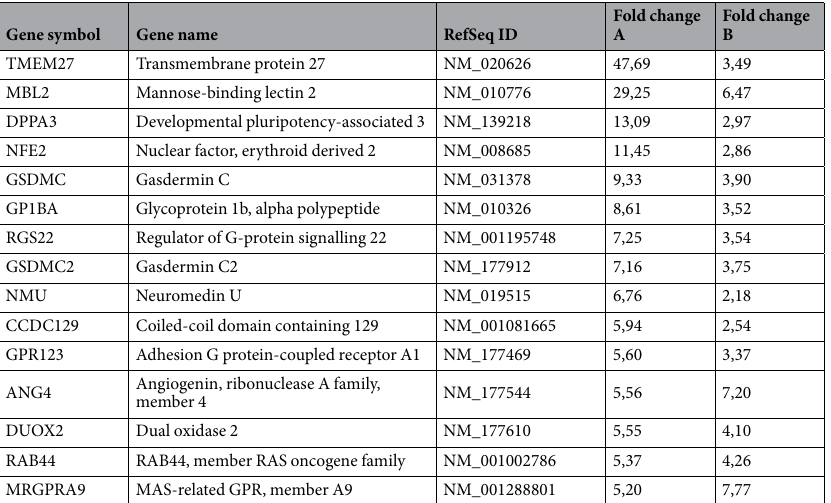
Table 3. Top 15 most upregulated genes as identified by RNA-seq that differentially respond to infection in C57BL/6 WT infected mice versus C57BL/6 IL-17RA-KO infected mice (A) and also in WT infected mice versus WT uninfected controls (B).